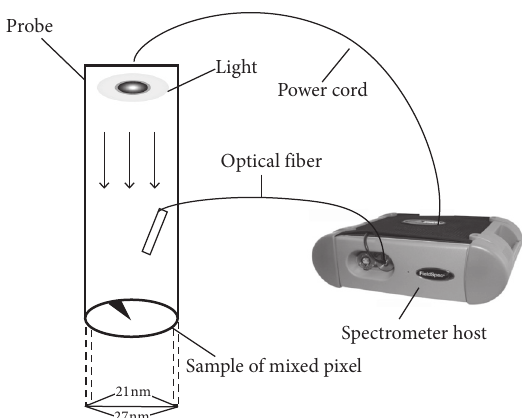
Figure 2: The experimental design of spectral